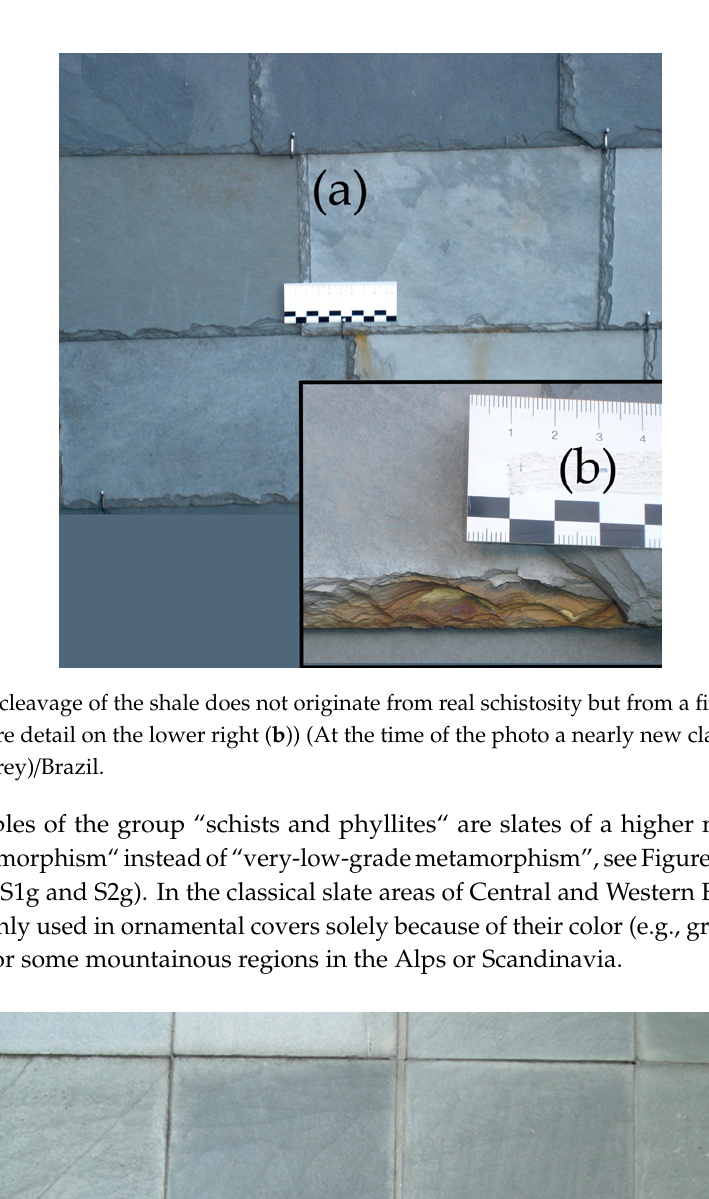
Figure 8. Phyllitic Quartzite facade panels (transverse length = 50 cm) (almost 60 years old); Alta Quartzite/Norway.